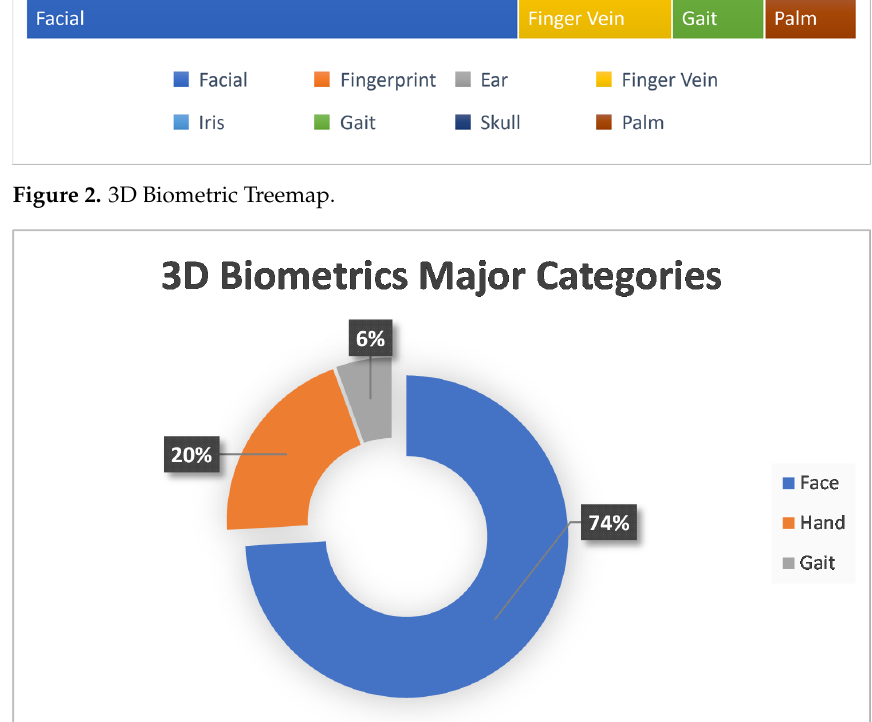
Figure 3. Three-Dimensional (3D) Biometrics Major Categories.